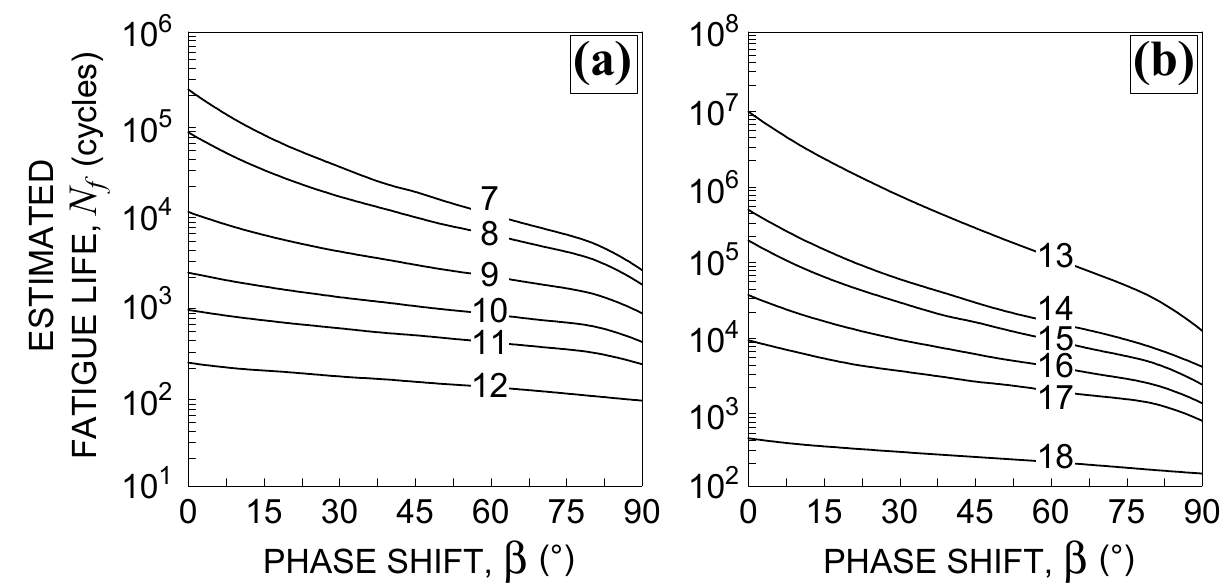
β β ° ≤ ≤ ° Figure 11. Influence of the phase shift ( 0 90 ) on fatigue life estimation using the refined equivalent de- Figure 11. Influence of the phase shift β ( 0 ◦ ≤ β ≤ 90 ◦ ) on fatigue life estimation using the refined equivalent deformation